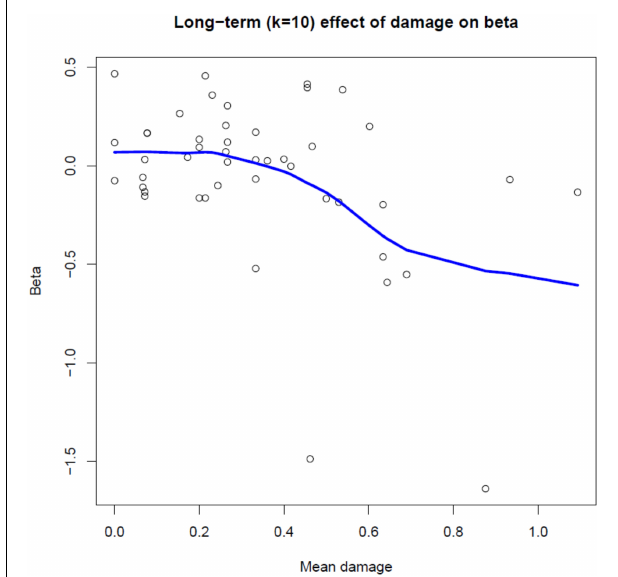
FIGURE 4 | Scatterplot of estimated regression slope parameters from step 1 (Eq. 2) versus mean damage for individual Norway spruce trees, with a superimposed local linear regression curve ( P = 0.002). The figure shows the long term (10-year window; k = 10) effect of mean damage on the relation between defoliation (%) and growth (ring widths in mm, Eq.